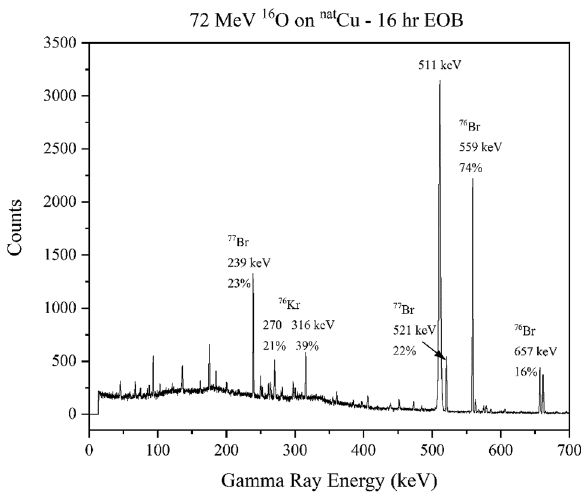
Figure 7. A gamma-ray spectrum resulting from the bombardment of 72 MeV 16 O onto nat Cu. The spectrum was counted for 30 min beginning 16.2 h EOB. There is significant positron annihilation, as well as strong signatures of 77 Br, 76 Br and 76 Kr.